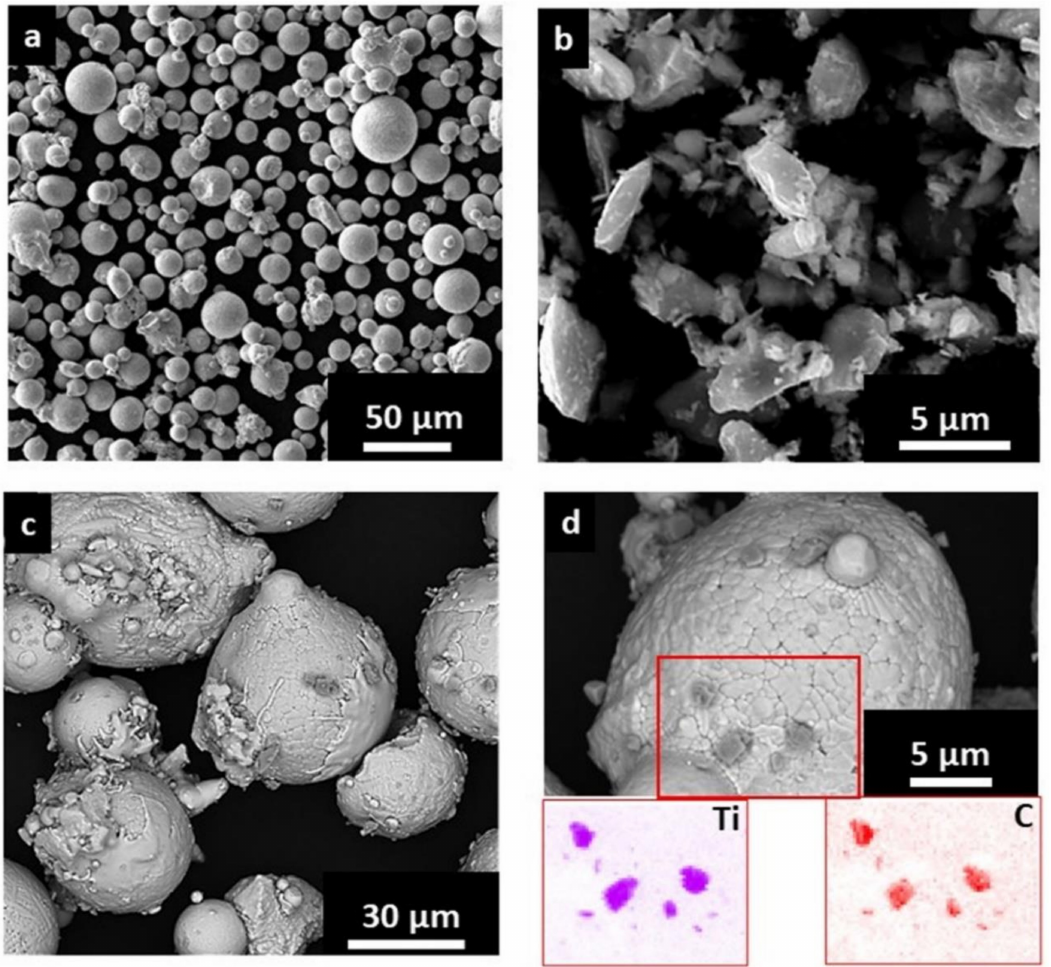
Figure 1. SEM images of the: ( a ) IN625 particles, ( b ) TiC particles, ( c ) mixed IN625/TiC particles, ( d ) SEM + EDS maps of an IN625 particle covered by small irregular TiC